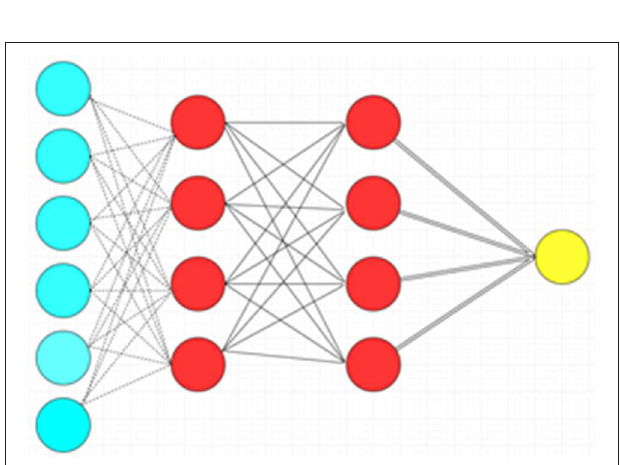
FIGURE 5 | Deep feedforward neural network with two hidden layers. Blue circles: Input layer. Red circles: Hidden layer. Yellow circle: Output